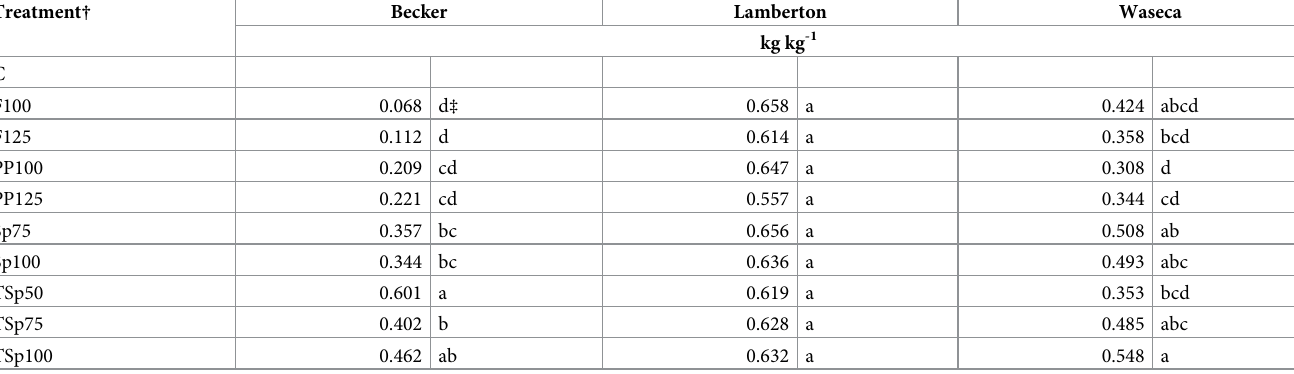
Table 10. Recovery efficiency of applied N fertilizer as affected by treatment and location, averaged across